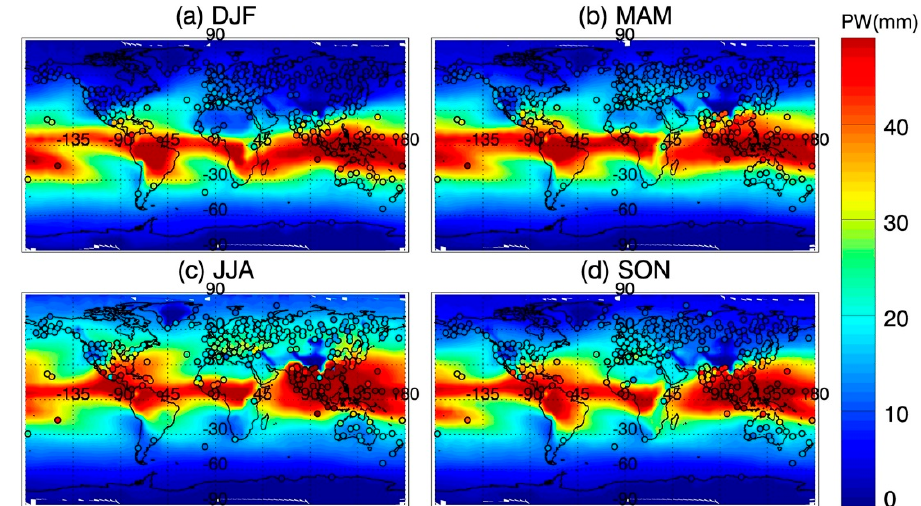
Figure 4. Global maps of mean seasonal PW from IGRA radiosonde observations (colored dots) and from COSMIC observations in the last 10 years.